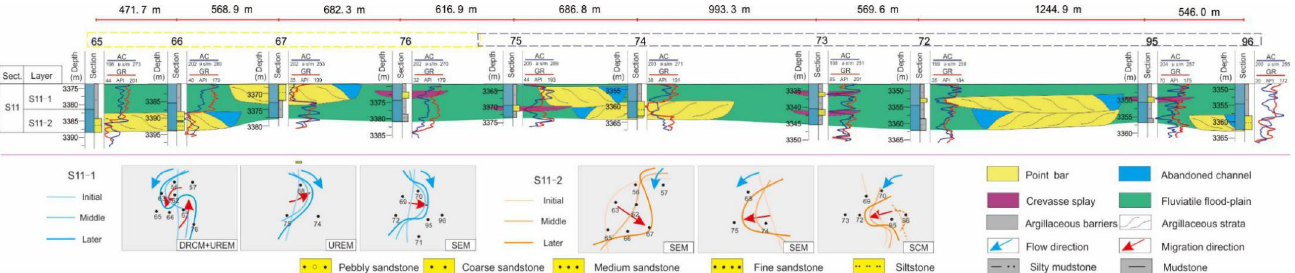
Figure 18. Profile T11 of comprehensive analysis including evolution model of meander bend-based multiple connected core wells which are collected from database in S 11 sublayer of Su-X block, Sulige gas field, Ordos Basin, China: migration areas Z3 (yellow frame), Z4(gray frame).